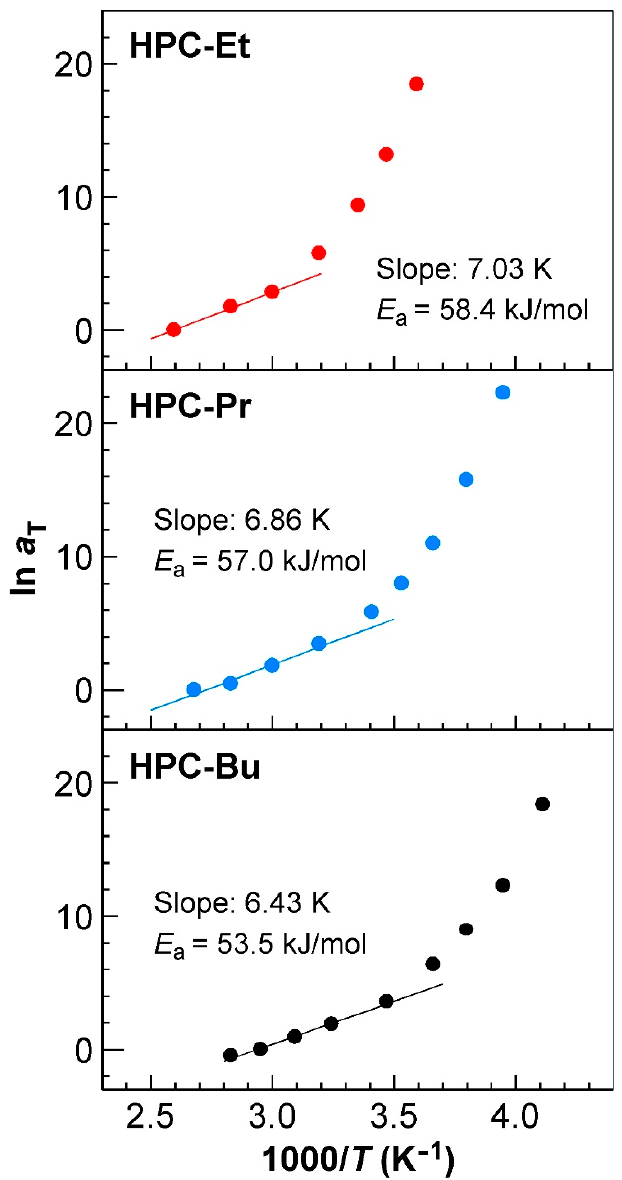
Figure 6. Arrhenius-type plots of the a T values of HPC-Et ( upper panel ), HPC-Pr ( middle panel ), and HPC-Bu ( lower panel ). The solid lines represent their regression lines of a T in the high-temperature region. The activation energies ( E a ) of the HPC derivatives were calculated from the slopes of regression lines, as noted in the figures.